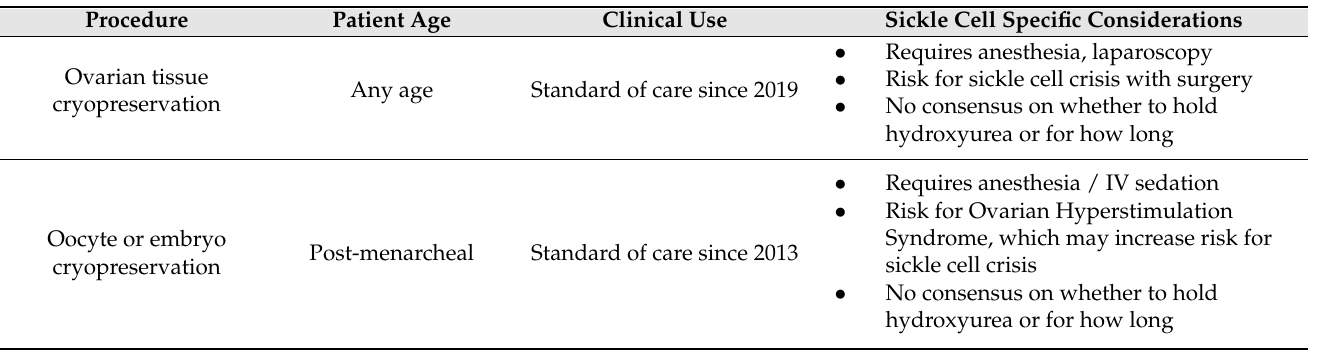
Table 2. Fertility preservation